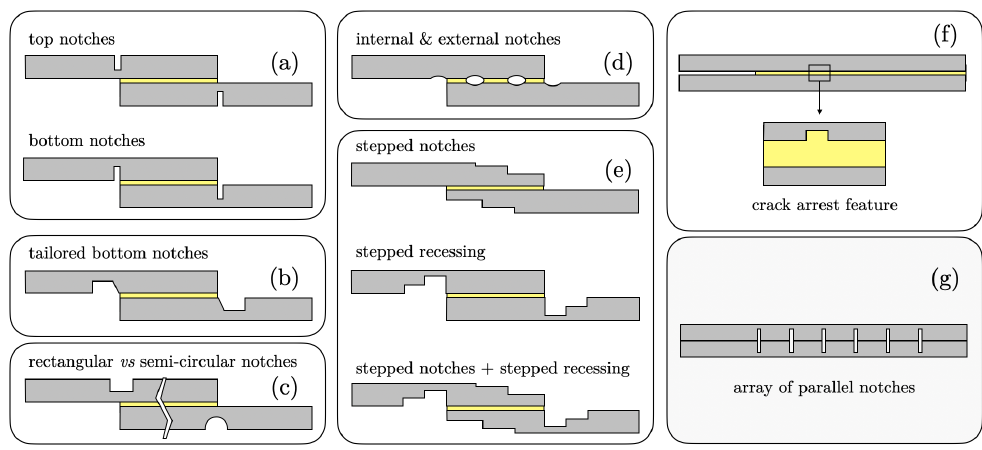
Figure 1. Schematics of adhesive joints with notched adherends. ( a – f ) Solutions proposed in pre- vious related studies [15–21]; ( g ) adhesive-bonded DCB with notched adherends analysed in the present